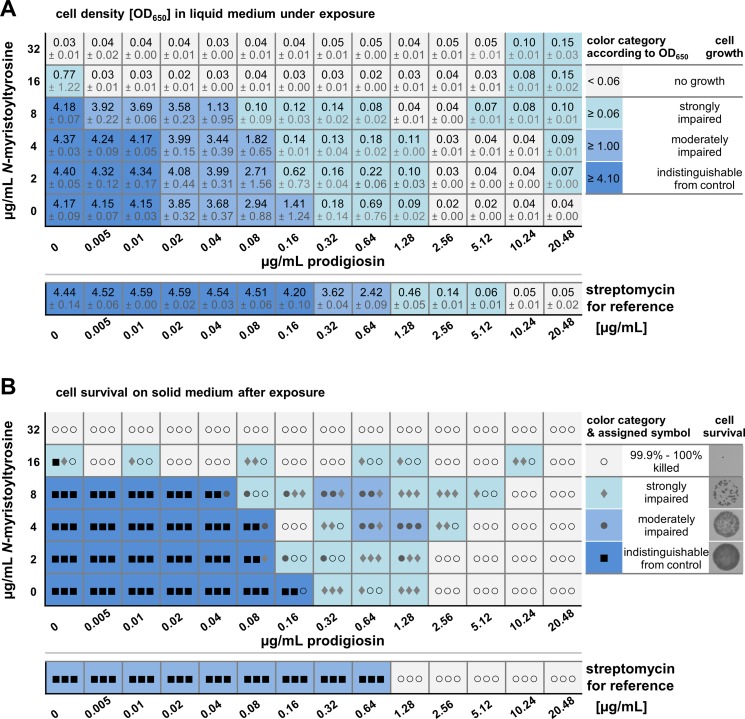
Growth and survival of C. glutamicum under combined exposure to prodigiosin and N-myristoyltyrosine.Liquid cultures (volume 800 μL) of C. glutamicum were supplemented with antibiotic compounds in a checkerboard matrix individually and in combinations in two-fold dilutions. The antibiotic streptomycin was individually applied for reference. (A) Turbidities of cultures were measured at 650 nm after incubation for 20 h at 30°C and constant agitation. Grey: Turbidities up to 0.06, defined as no growth. Different shades of blue: Strongly impaired growth with turbidities from 0.06 to 1.00, moderately impaired growth with turbidities from 1.00 to 4.10, and unimpaired growth with turbidities above 4.10. Values represent mean results from three independent measurements and the respective standard deviation. (B) Grown cells were washed and diluted samples spotted onto solid medium without antibiotics for incubation at 30°C for 20 h. Colony formation was evaluated by assignment of categories according to cell survival: killed (grey, empty circle), strongly impaired (light-blue, filled diamond), moderately impaired (blue, filled circle), and fully grown like the control (dark-blue, filled squares). Symbols in the table represent respective results from three independent experiments.